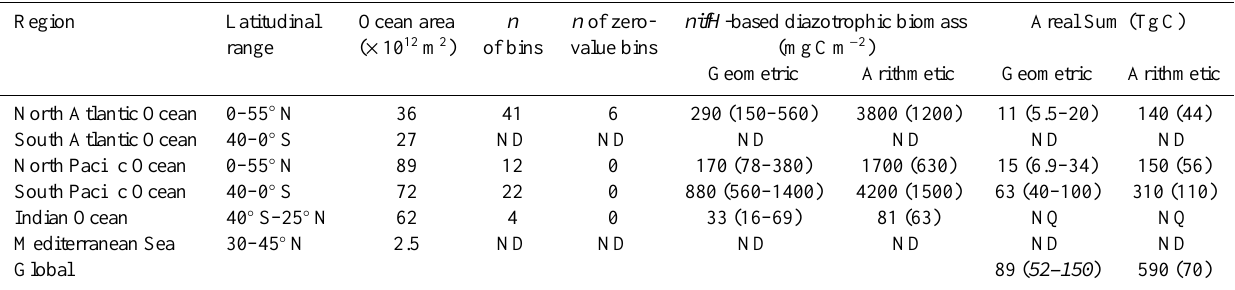
Table 8. Estimates of diazotrophic biomass for the global oceans using nifH -based data. Same method as Table 6 is used. ND: no data. NQ: not qualified to calculate areal sum because of too few